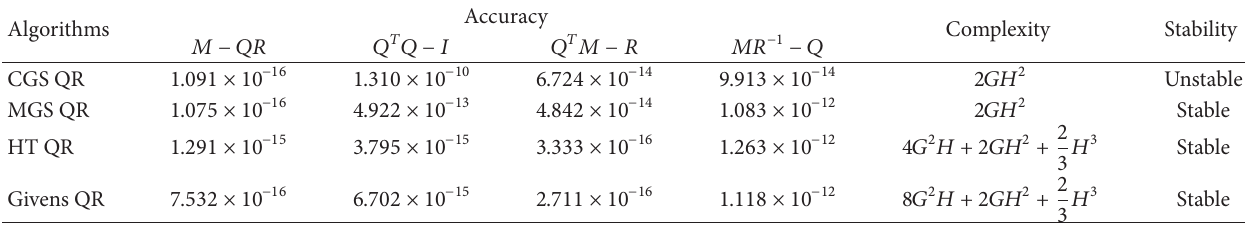
Table 1: Comparison analysis of QRD algorithms for